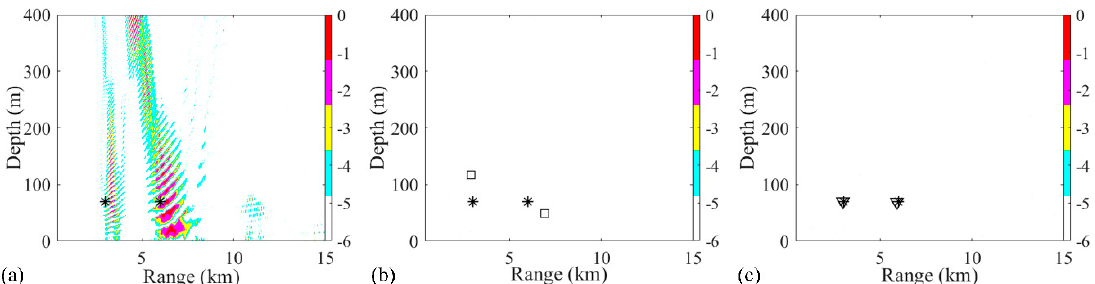
Figure 3. Ambiguity surfaces from the simulated data at 187 Hz for the localization of two sources using ( a ) the Bartlett processor, ( b ) the RAMP method, and ( c ) the RAMPMF method. True source positions and the positions estimated by the RAMP and RAMPMF methods are represented as black asterisks, squares, and inverted triangles, respectively.